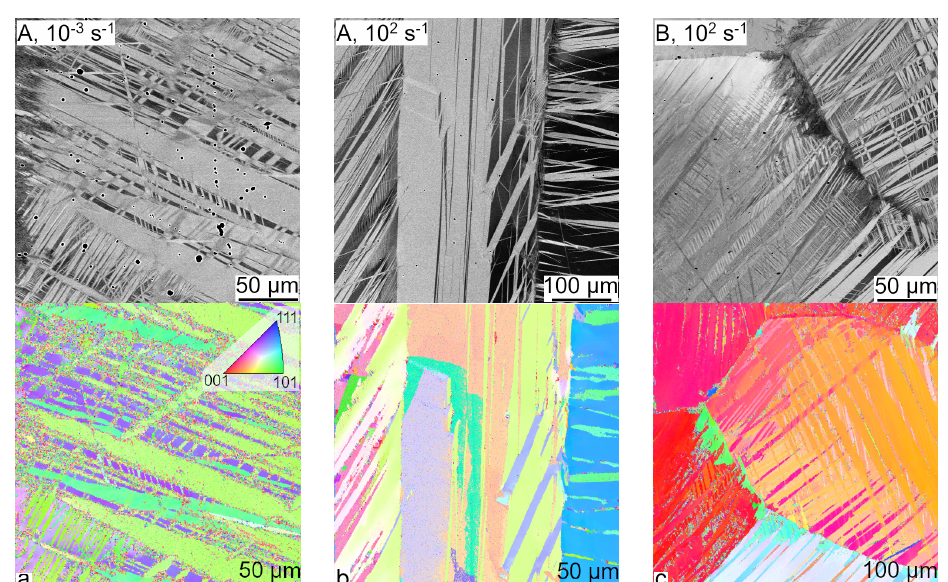
Fig. 5: Phase transformation near the fracture surfaces (distance ca. 0.5–1 mm) for material A (a + b) and material B (c). Upper row: BSE contrast, lower row: orientation maps (inverse pole figure is valid for all maps). The loading direction is horizontal. The orientations of the grains are given with respect to the loading